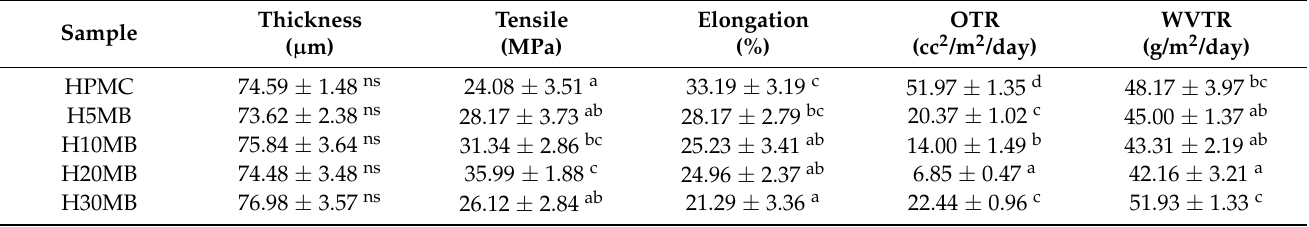
Table 1. Characteristics of the hydroxypropyl methylcellulose (HPMC), 5% microcrystalline